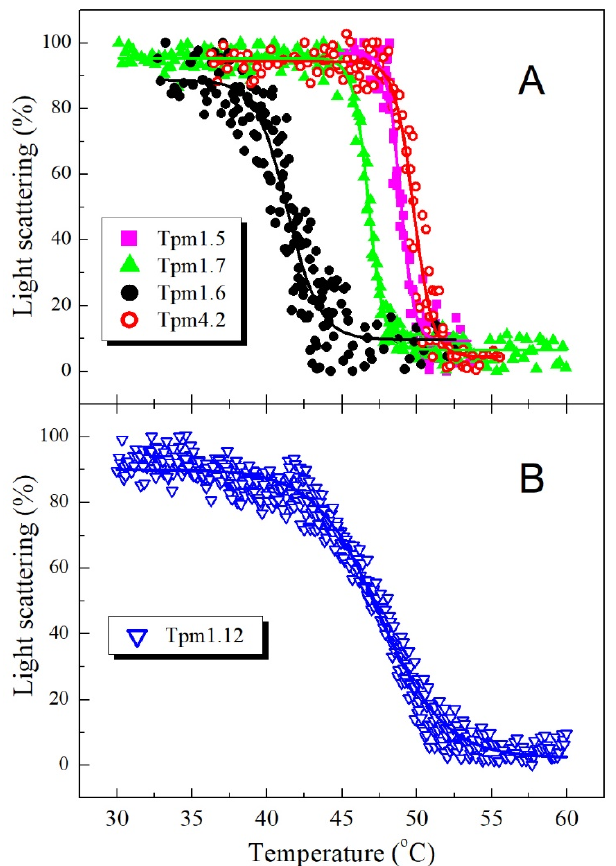
Figure 5. Normalized temperature dependences of dissociation of the complexes of F-actin with Tpm isoforms Tpm1.5, Tpm1.6, Tpm1.7, and Tpm4.2 ( A ), and Tpm1.12 ( B ). A 100% value corresponds to the difference between the light scattering of Tpm–F-actin complexes measured at 25 °C and that of pure F-actin stabilized by phalloidin, which was temperature-independent within the temperature range used. A decrease in the light-scattering intensity reflects the dissociation of the Tpm–F-actin complex. Samples contained 20 µM F-actin stabilized by 20 µM phalloidin and 10 µM Tpm ( A ) or 10 µM phalloidin-stabilized F-actin and 120 µM Tpm1.12 ( B ) in 30 mM Hepes-Na buffer, pH 7.3, containing 100 mM NaCl and 2 mM DTT.